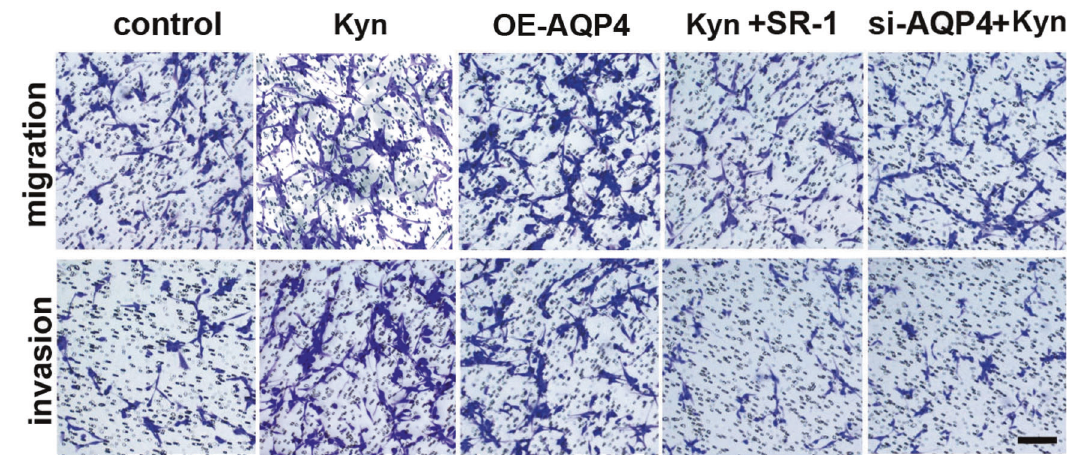
Fig. 6 g Migration and invasion assays of U87MG cells under different conditions (magni fi cation, ×200; scale bar, 100 μ m). The authors mistakenly placed the wrong representative images showing the migration and invasion abilities of U87MG cells in the Kyn group. The correct version of Fig. 6g is shown